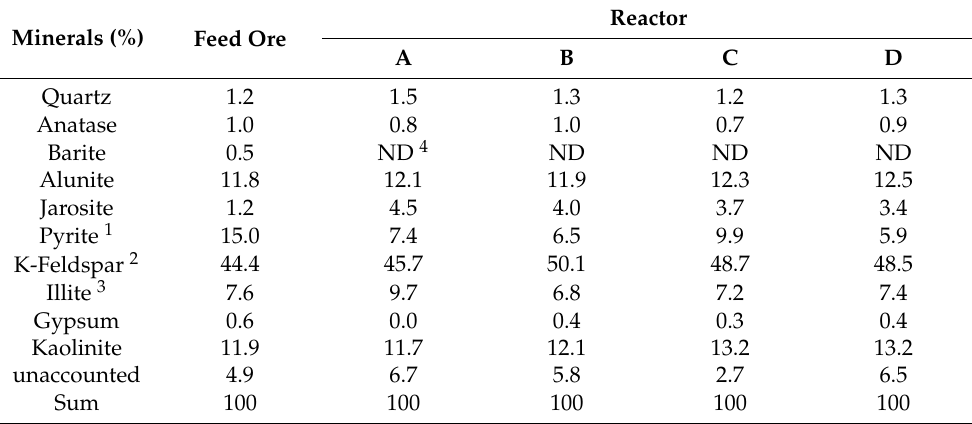
Table 6. Mineralogical composition of feed ore and residues from pyrite oxidation experiment analysed using QXRD.